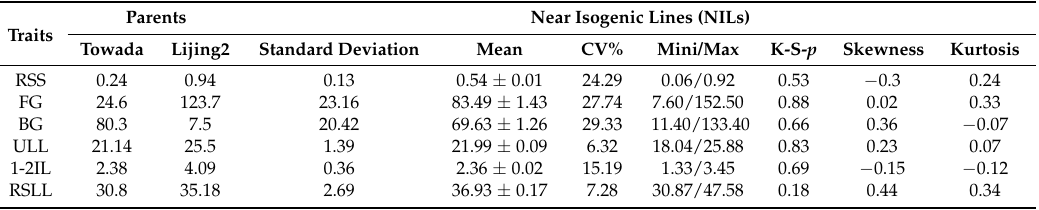
Table 3. Variation from mean value (Standard Deviation, Std. D), coefficient of variation (CV), measure of symmetry (Skewness), normal distribution of data (Kurtosis) and significant differences (K-S- p ) of six morphological traits including, rate of seed setting (RSS), full grains (FG), blighted grains (BG), uppermost leaf length (ULL), 1st and 2nd internode length (1-2 IL) and reciprocal secondary leaf length (RSLL), and correlated with cold tolerance at booting stage of NILs of japonica